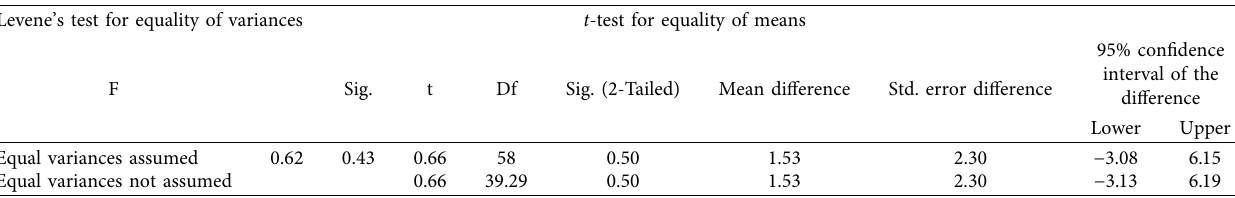
Table 2: Inferential statistics of the experimental and control groups in the anxiety pretest.